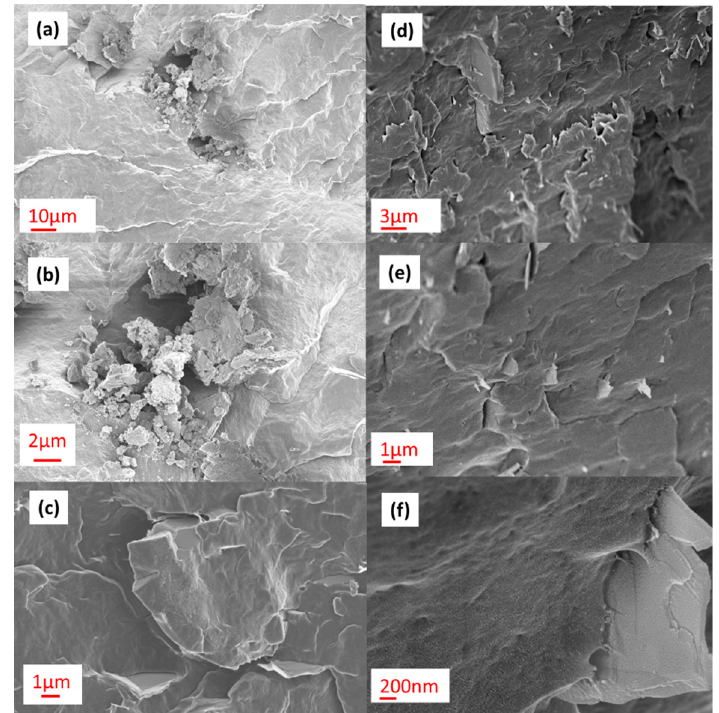
Figure 2. Scanning electron microscopy (SEM) images of a composite of PP and 5 wt % graphene nanoplatelets (GNPs) prepared by the laboratory scale extruder ( a – c ) and the 16-mm extruder ( d – f ) at different magnifications.